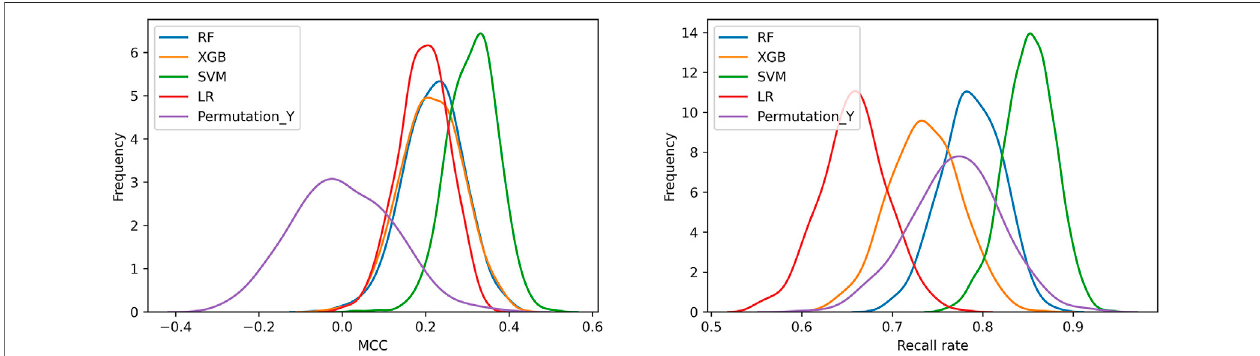
FIGURE2| ThedistributionofMCCsandrecallratesachievedbySVM,LR,RF,andXGBoostwith1,000iterationsof fi ve-foldcross-validation. (A) Thedistribution of MCCs. (B) The distribution of recall rates. Permutation_Y indicated that the SVM models constructed by using the samples with randomly permutated labels.